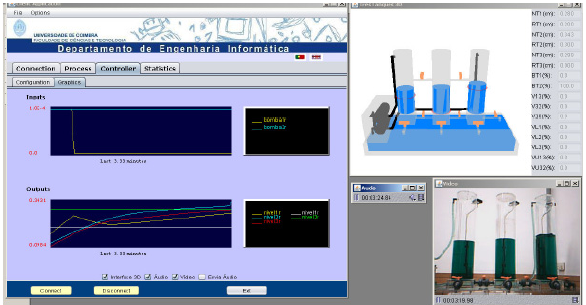
Figure 8. Interface of the remote lab using the three-tank system (DCS200) in Experiment 3.